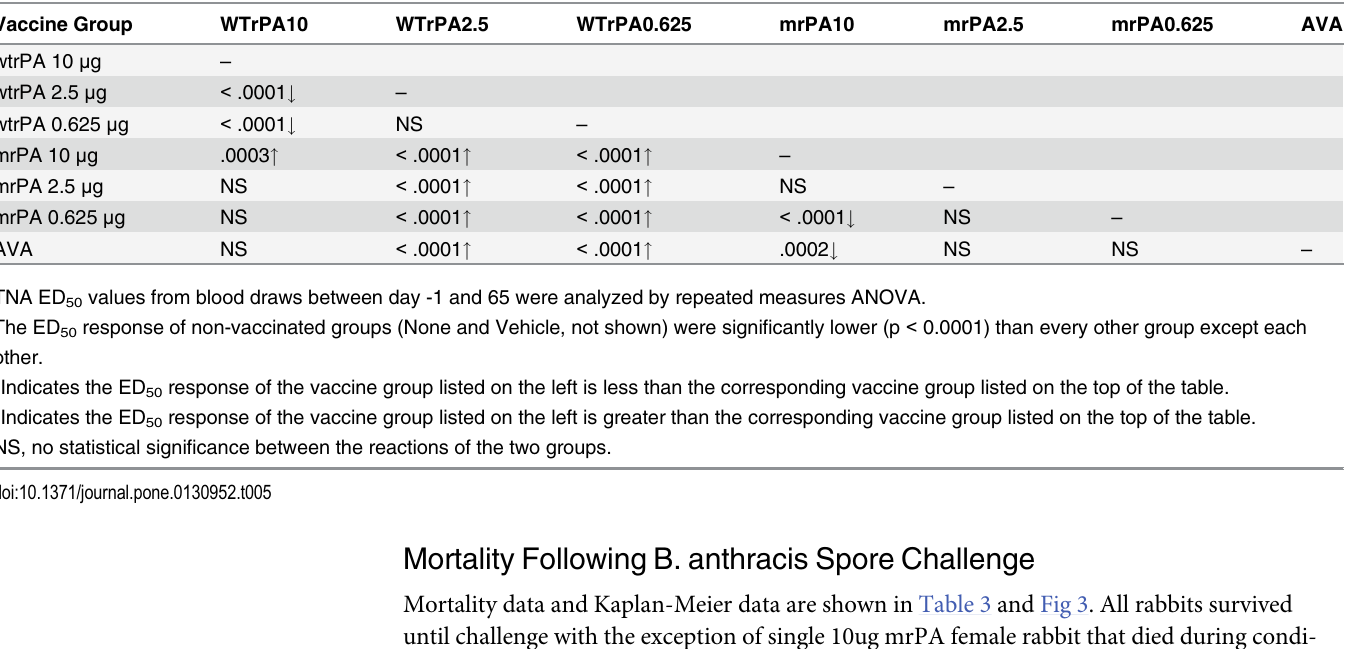
Table 5. p Values Associated with Comparison of ED50 Values between Vaccine Groups as Analyzed by Repeated Measures ANOVA Vaccine Group